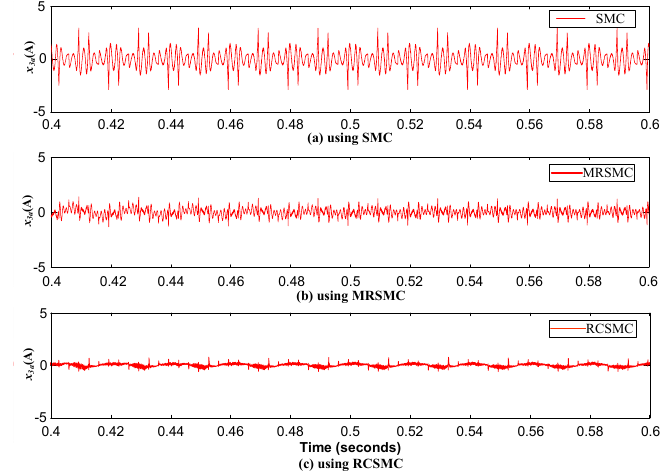
Figure 8. Waveform of x 3 a ( t ) using different control strategies.